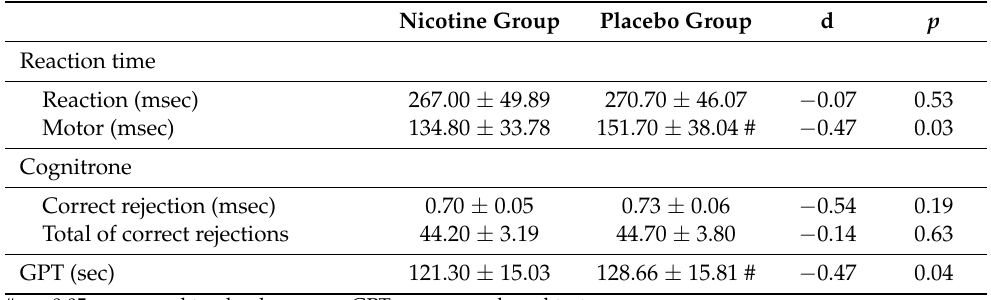
Table 3. The cognitive function in both